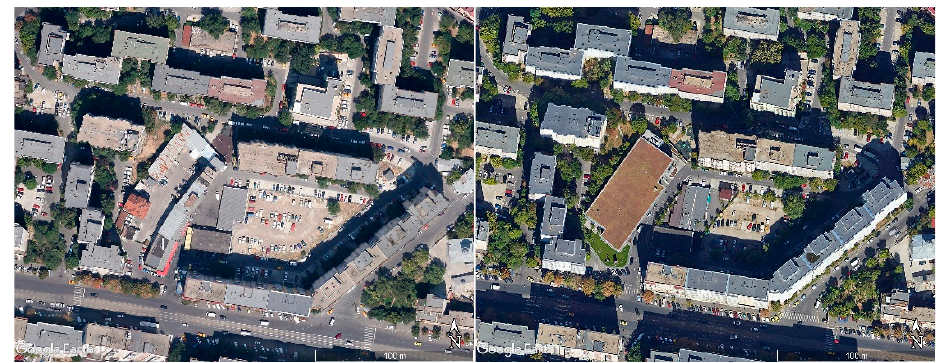
Figure 16. Analysed area ( left : before constructing the shopping centre, right : after the construction).